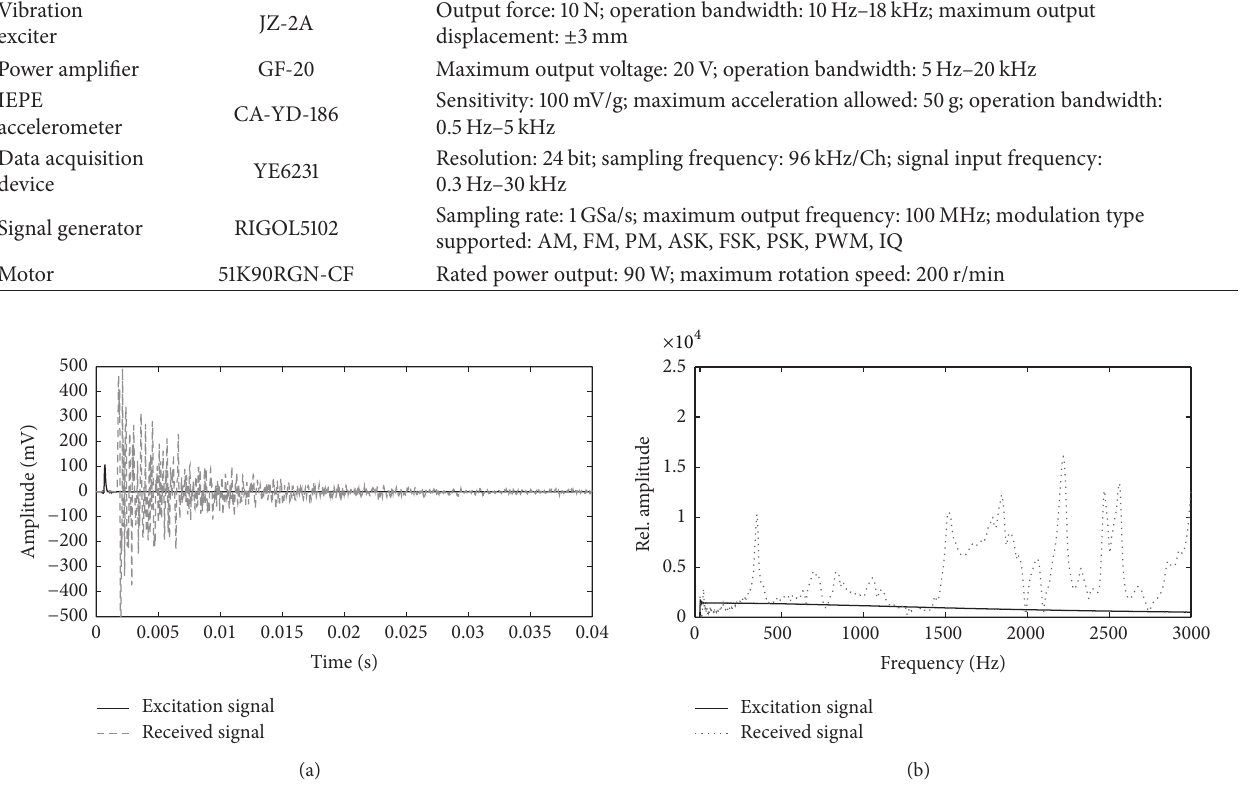
Figure 10: The measured hammer excitation and channel response signals. (a) Time-domain signal, (b) frequency-domain signal.